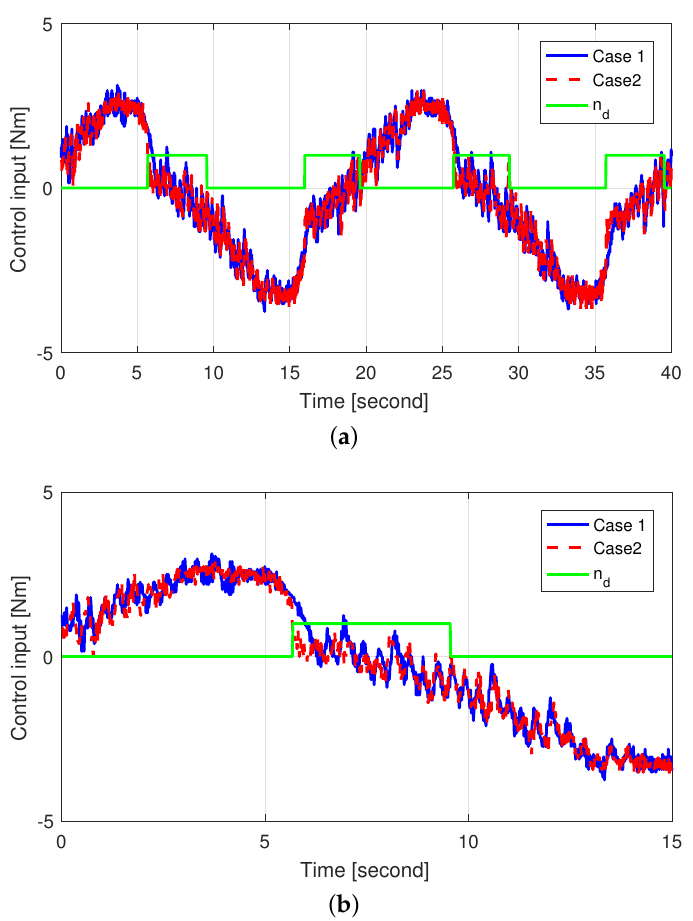
Figure 8. Control input in cases 1 and 2 ( a ) Zoomed-out and ( b )